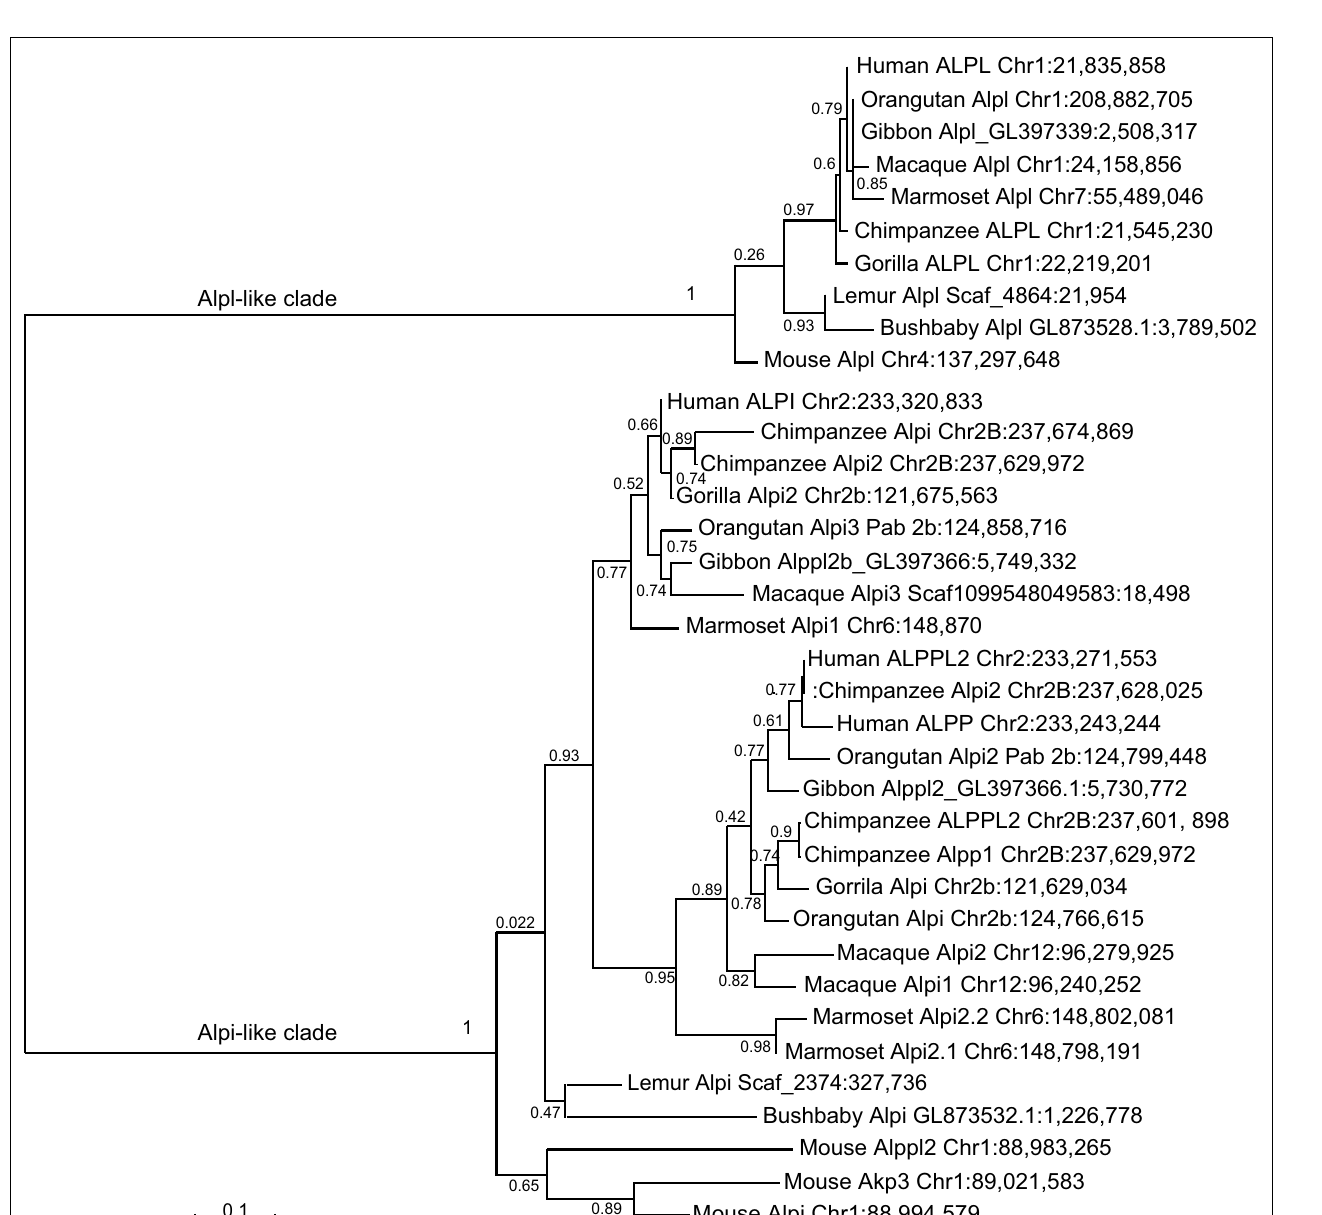
FIGURE 6 | Maximum likelihood tree of primate Alp sequences. After the divergence of the Strepsirrhini (lemur and bushbaby) lineage from the Haplorrhini lineages, a tandem gene duplication produced an Alpi- like gene and an Alpp -like gene with further duplications within some of the Haplorrhini